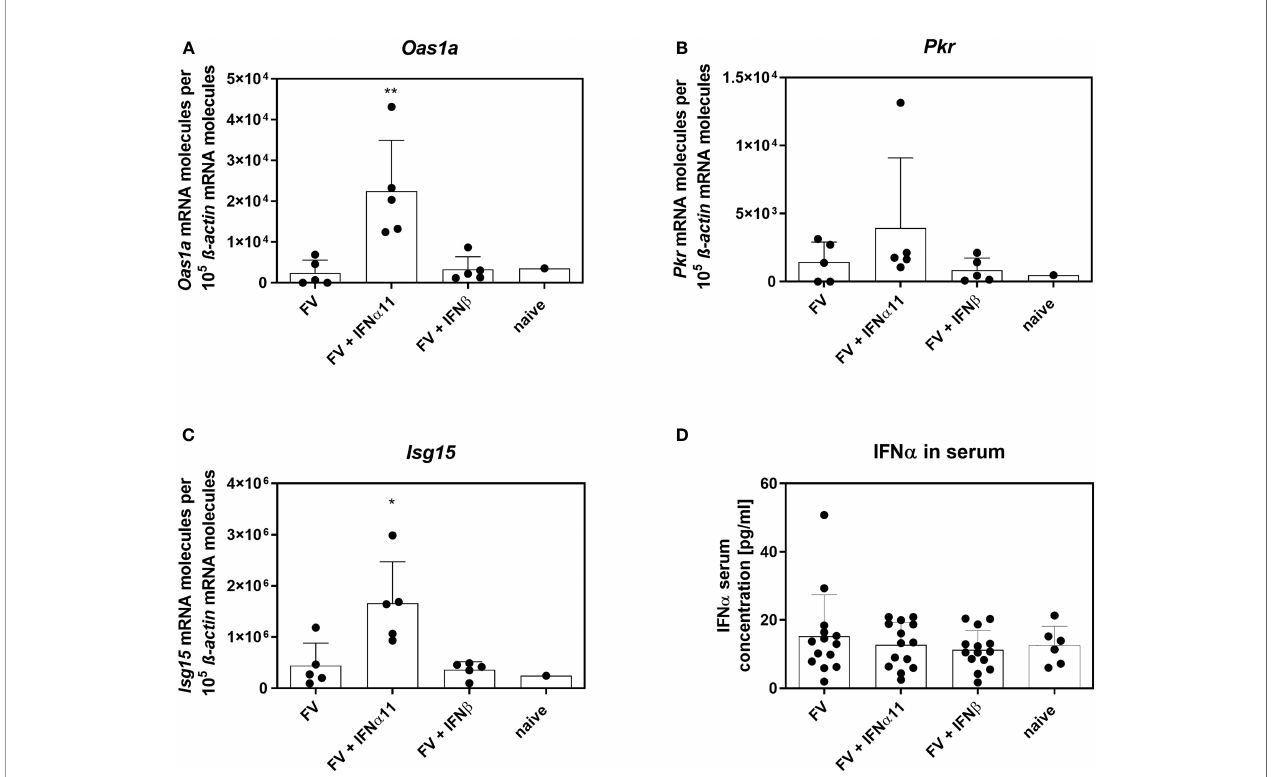
FIGURE 3 | IFN signature in chronically FV-infected mice. C57BL/6 mice were infected with 20,000 SFFU of FV and additional 100,000 FFU of F-MuLV. Mice were treated daily with 8000 units of IFN a 11 or IFN b from day 40 to 44 mice. At day 45 post infection, mice were sacri fi ced and splenocytes were analyzed for ISG mRNA expression (A – C) . IFN a serum concentrations of chronically FV-infected mice were determined by ELISA at 45 dpi (D) . Five mice per group (A – C) and 14 mice per group pooled from three independent experiments (D) were analyzed and the mean values for each group are indicated by a bar (+SEM). Statistically signi fi cant differences between the control group (FV) and the groups of IFN-treated mice (FV + IFN a 11 or FV + IFN b ) were tested using Kruskal-Wallis one-way and Dunn ’ s multiple comparison and are indicated by *p < 0.05, **p <